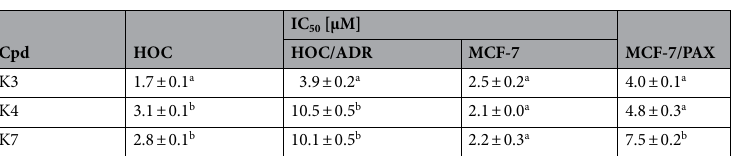
Table 7. Cytotoxic activity of selenoesters against 3D ovarian (HOC) and breast (MCF-7) cancer cell models and their Adriamycin (HOC/ADR) and paclitaxel (MCF-7/PAX) resistant sub-models. Data are expressed as the average inhibitory concentration (IC 50 ) of four repetitions with standard error of the mean (SEM). The statistical differences between compounds were calculated by one-way analysis of variance (ANOVA) and Duncan’s post hoc test (p ˂ 0.05) within one cell line, where different letters (a, b) denoted the significances; the different cell lines were evaluated independently on each